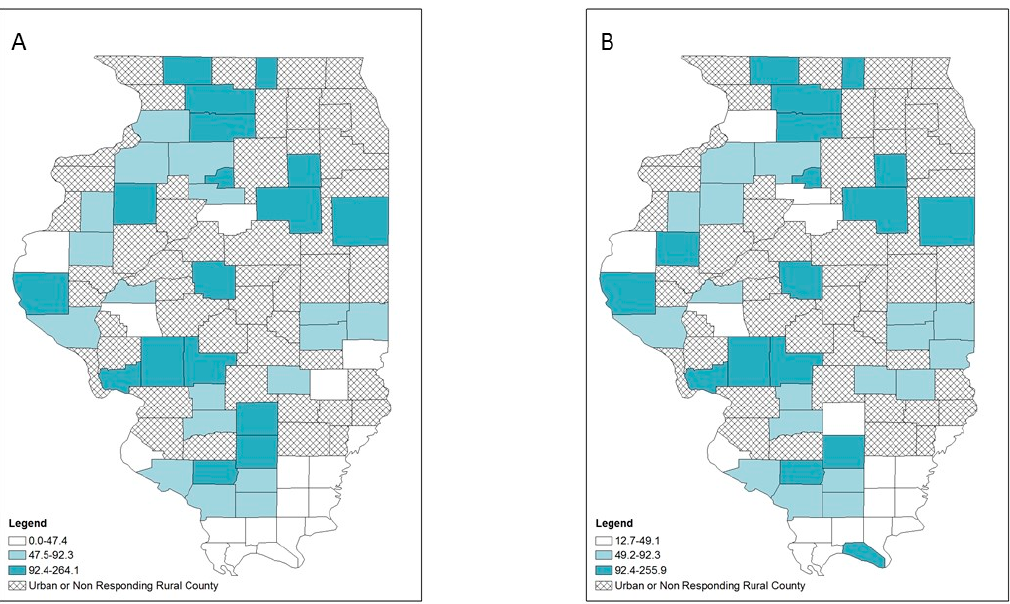
Figure 5. Opioid-related overdose rates per 100,000 population by tertiles, respondent rural counties, Illinois, 2016–2017: ( A ) crude rates; ( B ) empirical Bayes estimated rates.